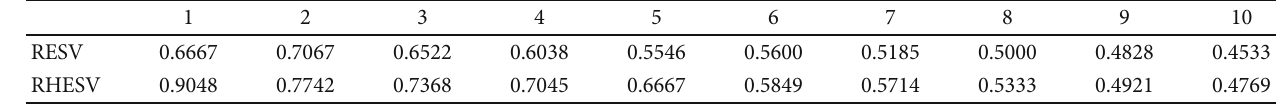
Table 2: The relative lifting rate of four targets.